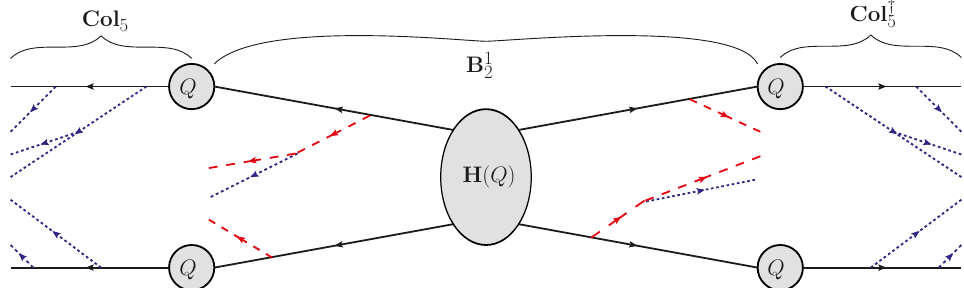
Figure 3. Illustrating hard-leg factorisation. Red dashed lines represent the emission of soft gluons and collinear emissions are represented by blue dotted lines. Circles indicate the hard scale from which subsequent evolution proceeds. Loops (Sudakov factors) have been neglected to avoid